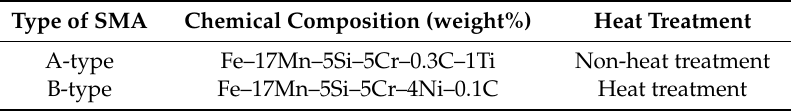
Table 1. Chemical composition of Fe-SMA